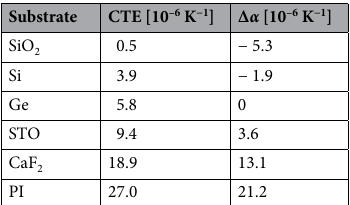
Table 1. CTEs and CTE differences between Ge and substrate (Δ α ).